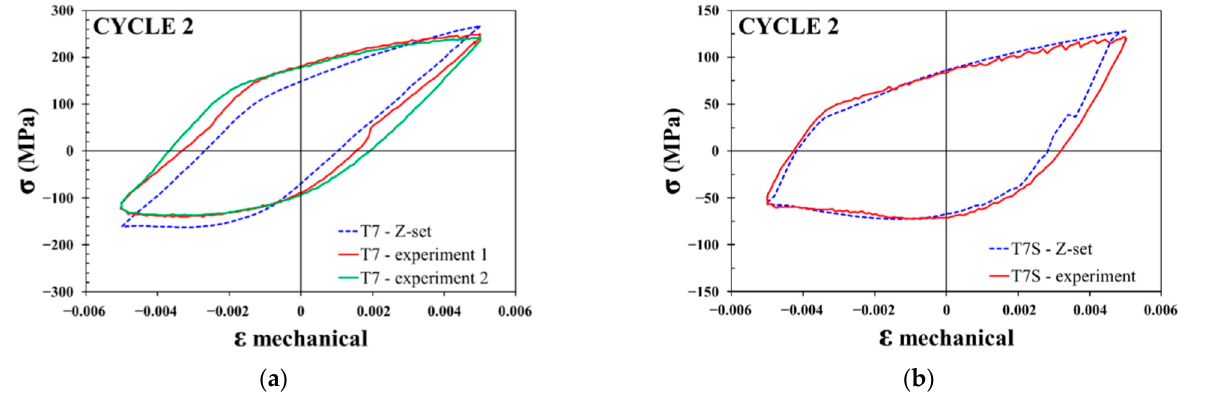
Figure 7. Hysteresis loops of mechanical strain-stress obtained by LM&C EV EP under condition ± 0.5% of ε mech ( a ) T7, and ( b ) T7S compared to experimental test.